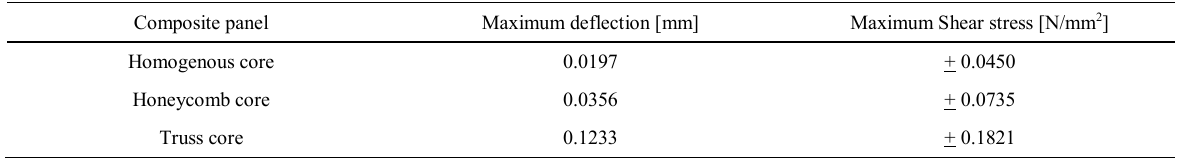
Table 3: Output FEM analysis with a load of 40